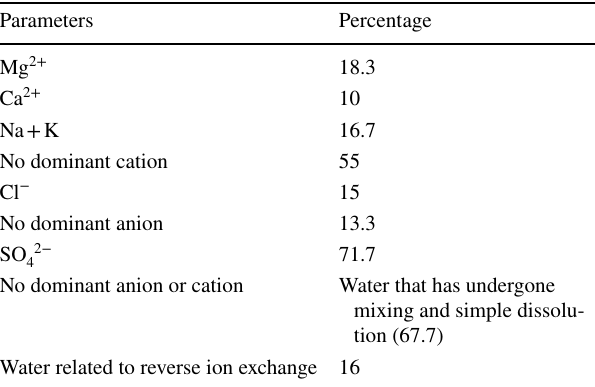
Table 4 Summary of result of hydrochemical facies from Durov dia-